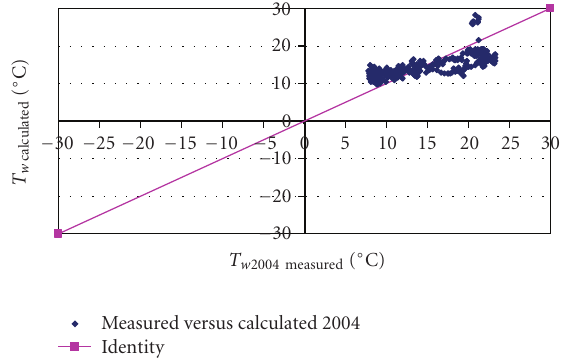
Figure 16: Measured and predicted water temperature for 2004, model without standardization (daily average values).